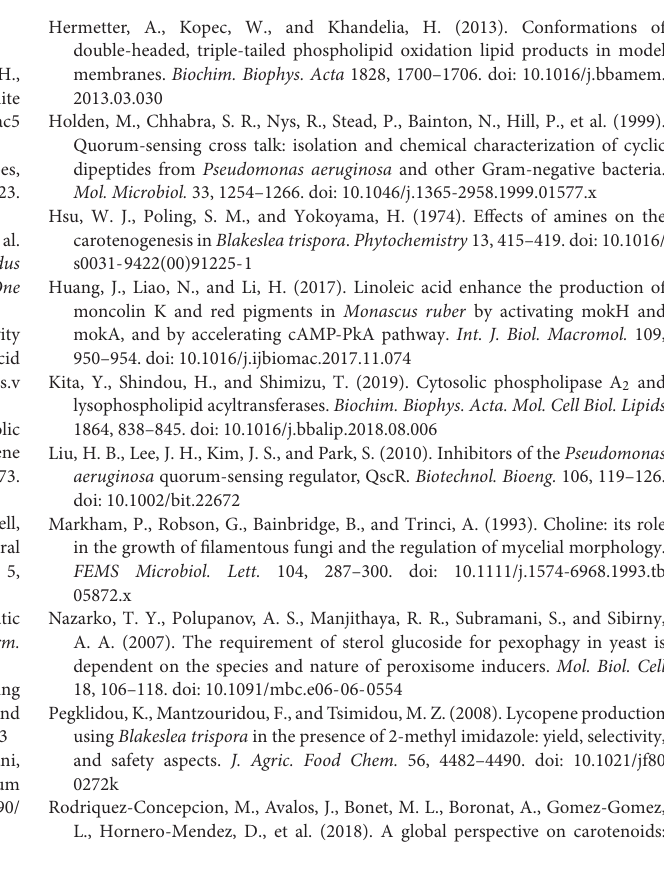
Supplementary Figure 1 | The total ion chromatograms of CG2 and TPA3 in positive and negative mode. Pos, positive mode; Neg, negative mode; TPA, tripropylamine treated group; CG, control group. Supplementary Figure 2 | The score chart of PCA and PLS-DA analyses. Pos, positive mode; Neg, negative mode; PC 1, principal component 1; PC 2, principal component 2; TPA, tripropylamine treated group; CG, control group. Supplementary Figure 3 | Glycine, serine and threonine metabolism in TPA treated B. trispora. Orange, up-regulated differential metabolites; Green, down-regulated differential metabolites. Supplementary Table 1 | Differential metabolites between TPA and CG in positive and negative modes. Supplementary Table 2 | Described differential metabolites between TPA and CG in positive and negative